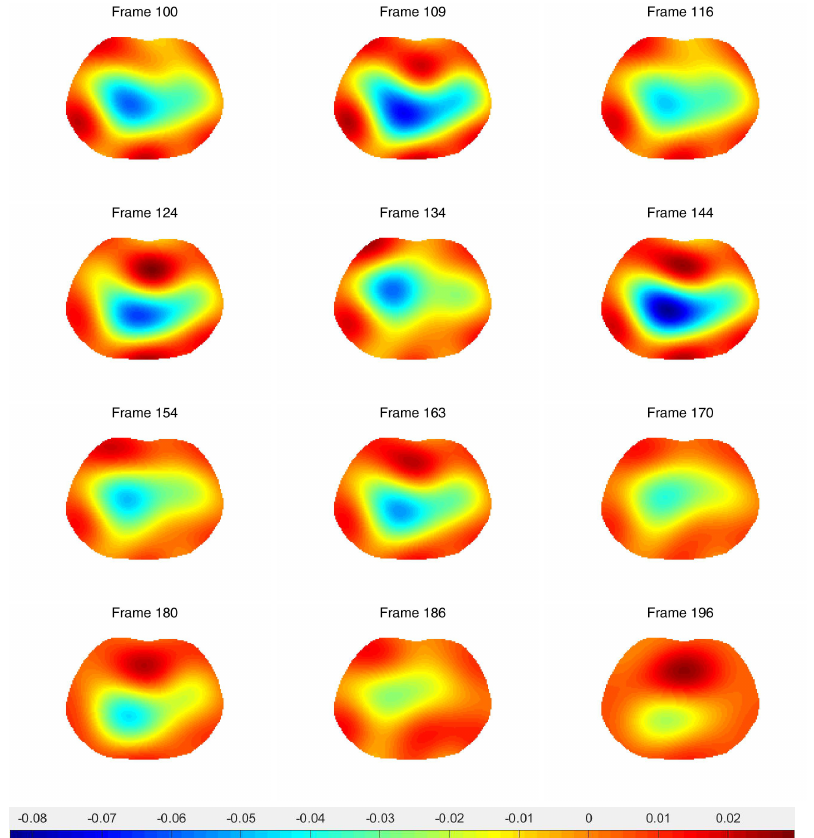
Figure 11. Difference images of breath holding data with no spatial prior included in the algorithm. Averaged voltage data were used for the reference data. The truncation radius is